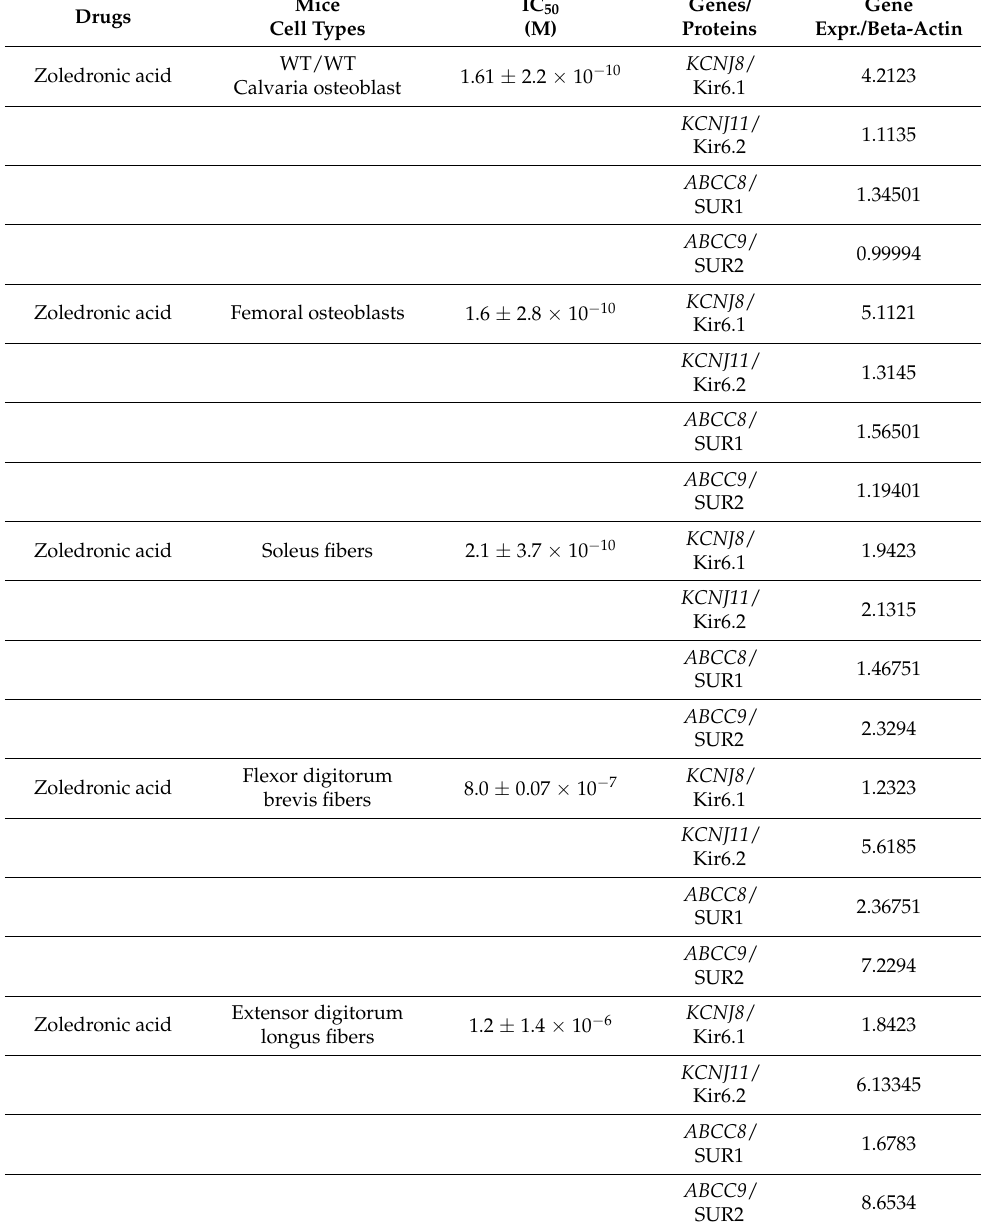
Table 2. Potency summary of zoledronic acid against the KATP channel currents in different cells and relative gene expression